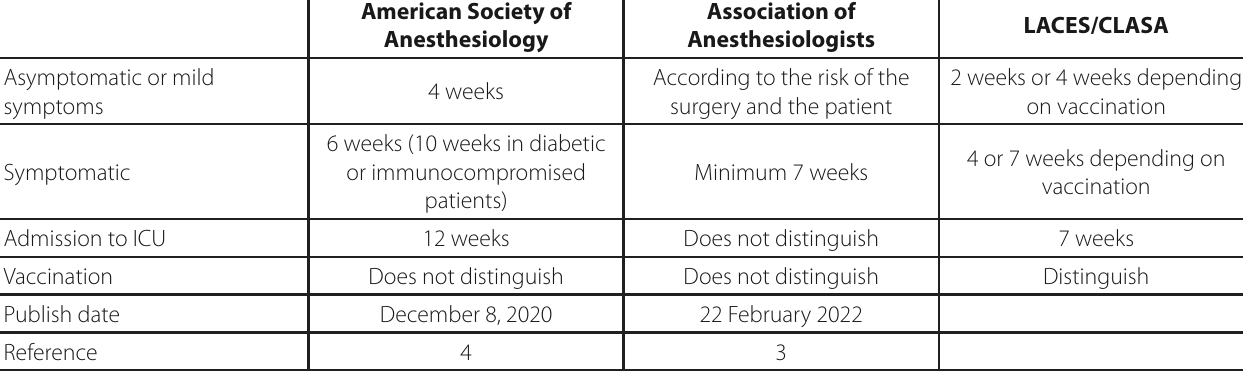
Table 2. Comparison between LACES/CLASA recommendations and other societies.